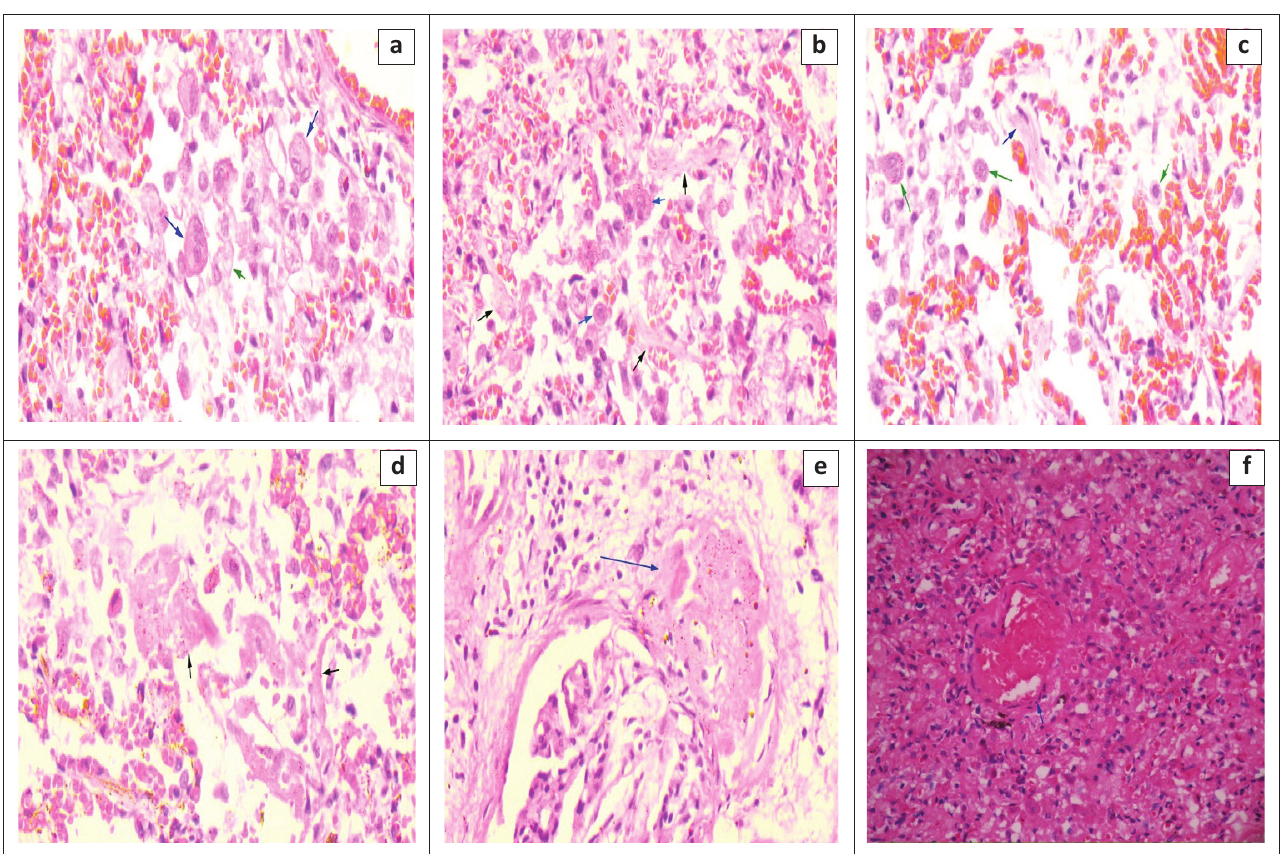
FIGURE 3: Haematoxylin and eosin staining of lung tissue samples from a 60 year old female patient with COVID-19 (37 Military Hospital, Accra, Ghana, April 2020). Case 2: (a) Alveolar sacs filled with alveolar macrophages (green arrow) and multinucleated giant cells (blue arrow) ×400. (b) Fibrous tissue proliferation in alveolar sacs (black arrow). Also noted are alveolar macrophages (blue arrow) ×400. (b) Fibroblast proliferation (green arrow) ×400. (d) Diffuse alveolar damage with prominent hyaline membrane formation (black arrow) x400. (e) Thrombus at the glomerulus (blue arrow) ×400. (f) Thrombus in a small pulmonary artery (blue arrow)